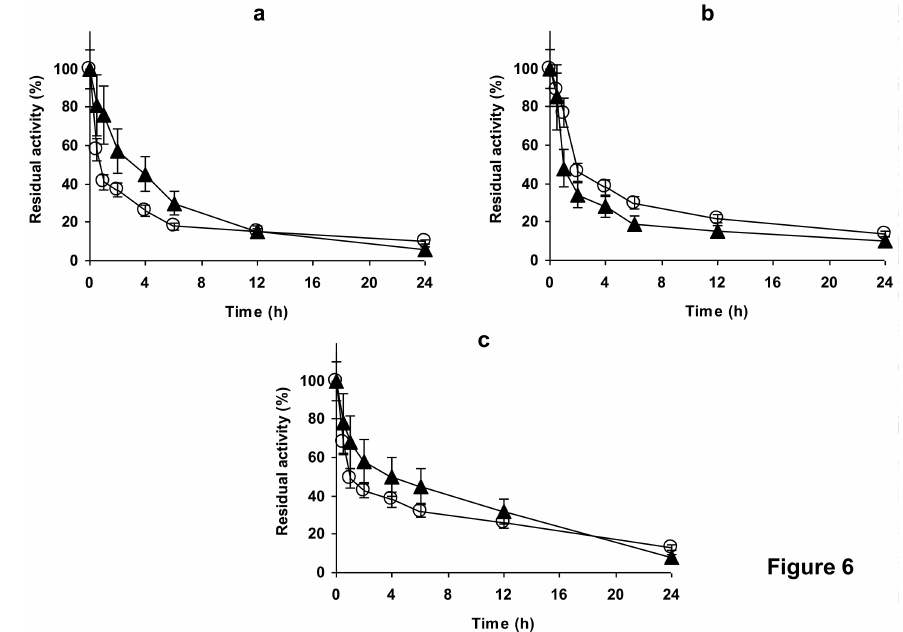
Figure 6. Inactivation courses of the ionically exchanged ficin extract on MANAE-agarose beads at pH 7. The inactivation studies were performed as indicated in Methods section at pH 5, ( a ), 7 ( b ) or 9 ( c ) at 55 ◦ C, using BANA as substrate. Circles: Free enzyme. Triangles: immobilized